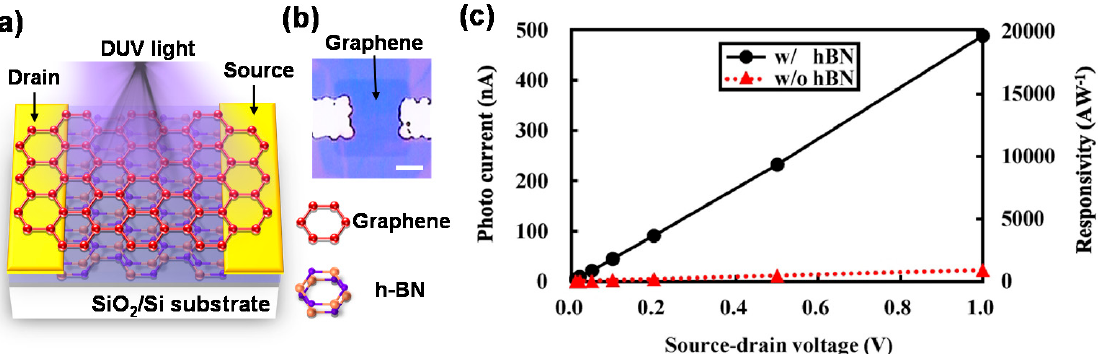
Figure 7. ( a ) Schematic and ( b ) optical microscopy image of hBN/graphene DUV photodetector (PD) prepared by photogating. Scale bar: 5 µ m. ( c ) Photocurrent and responsivity as a function of source–drain voltage for DUV-PDs with and without hBN. Figures are redrawn with permission from [70]. Copyright 2022 Optica.